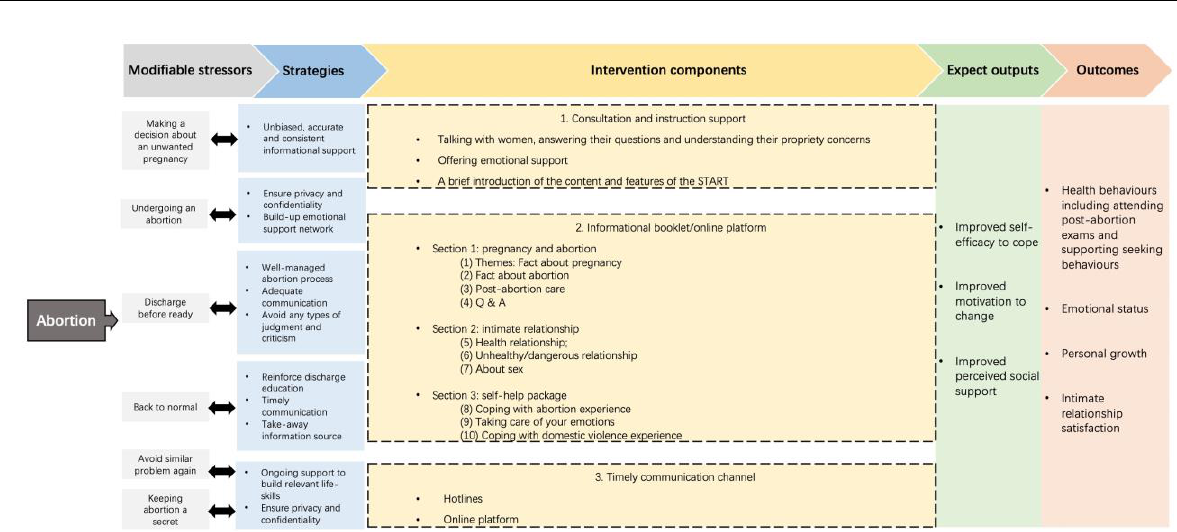
Figure 3. Logic model for the START intervention.